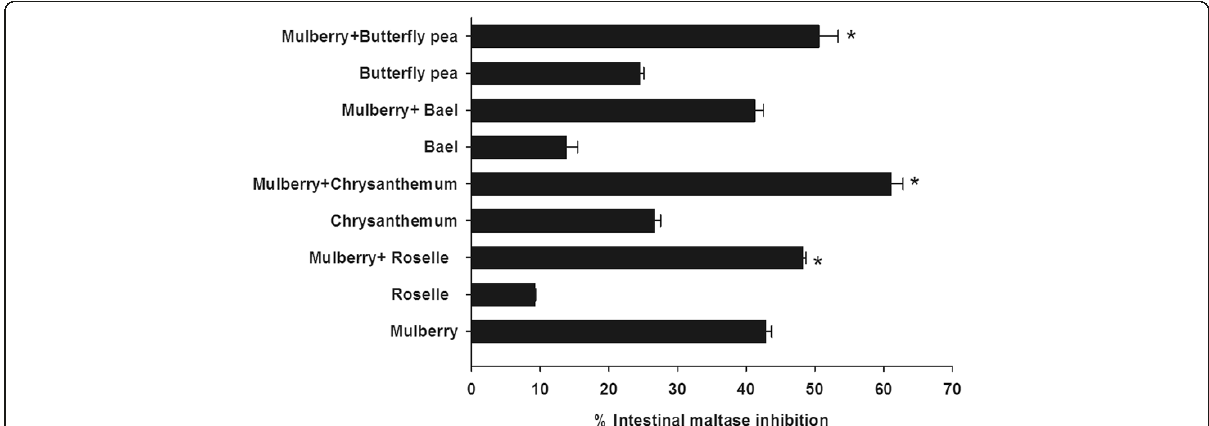
Figure 2 The percentage intestinal maltase of combinatorial plant-based foods (0.2 mg/ml) with mulberry (0.2 mg/ml). The results are expressed as means ± S.E.M., n=3. * P < 0.001 compared to mulberry alone.